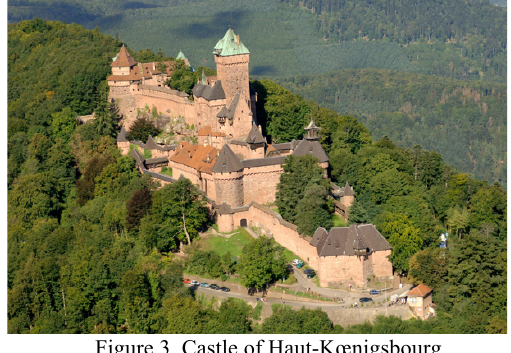
Figure 5. The total station data recording of the beam. Each beam collects at least six total station points.